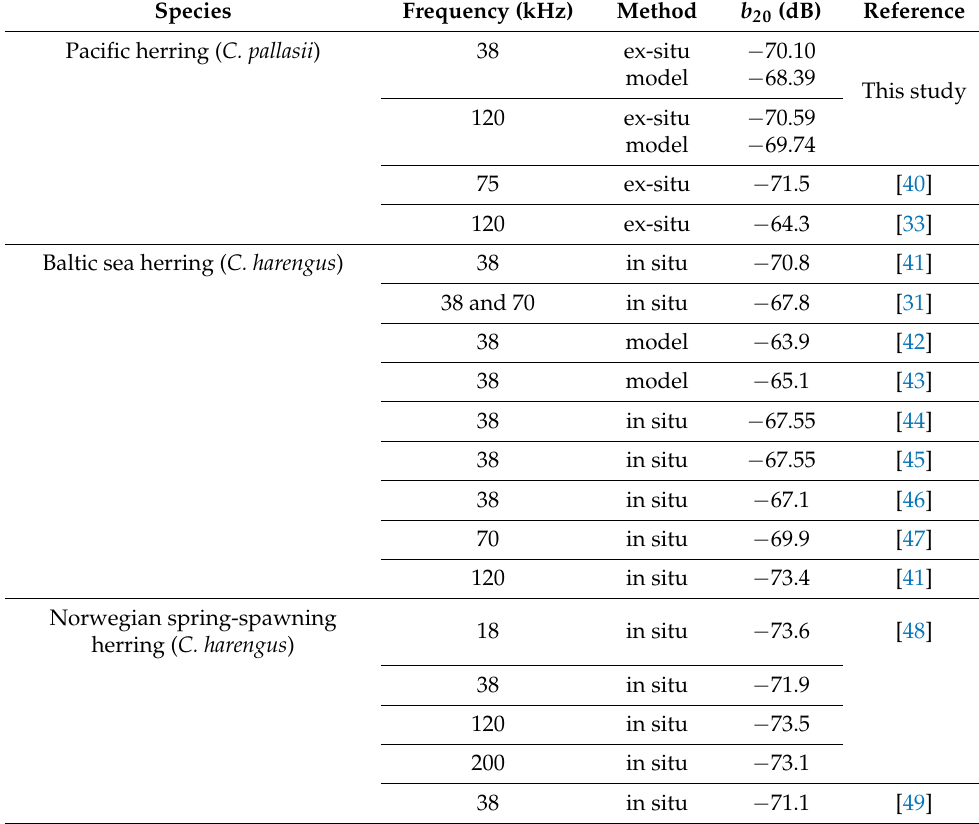
Table 2. Summary of target strength (TS)–length ( L ) relationship of this study and previous